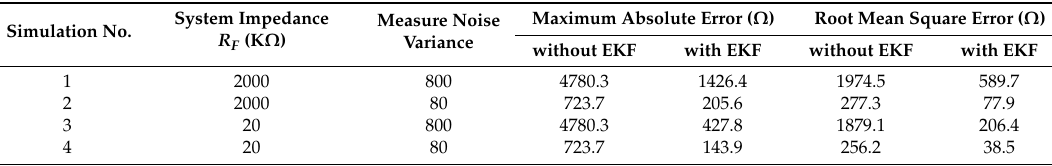
Figure 9. Simulink model of insulation detection: ( a ) The overall model of the detection circuit; ( b ) The Simulink model of the extended Kalman filter (EKF) and the noise. Table 1. Results of the simulation. R F : Reference Resistor.